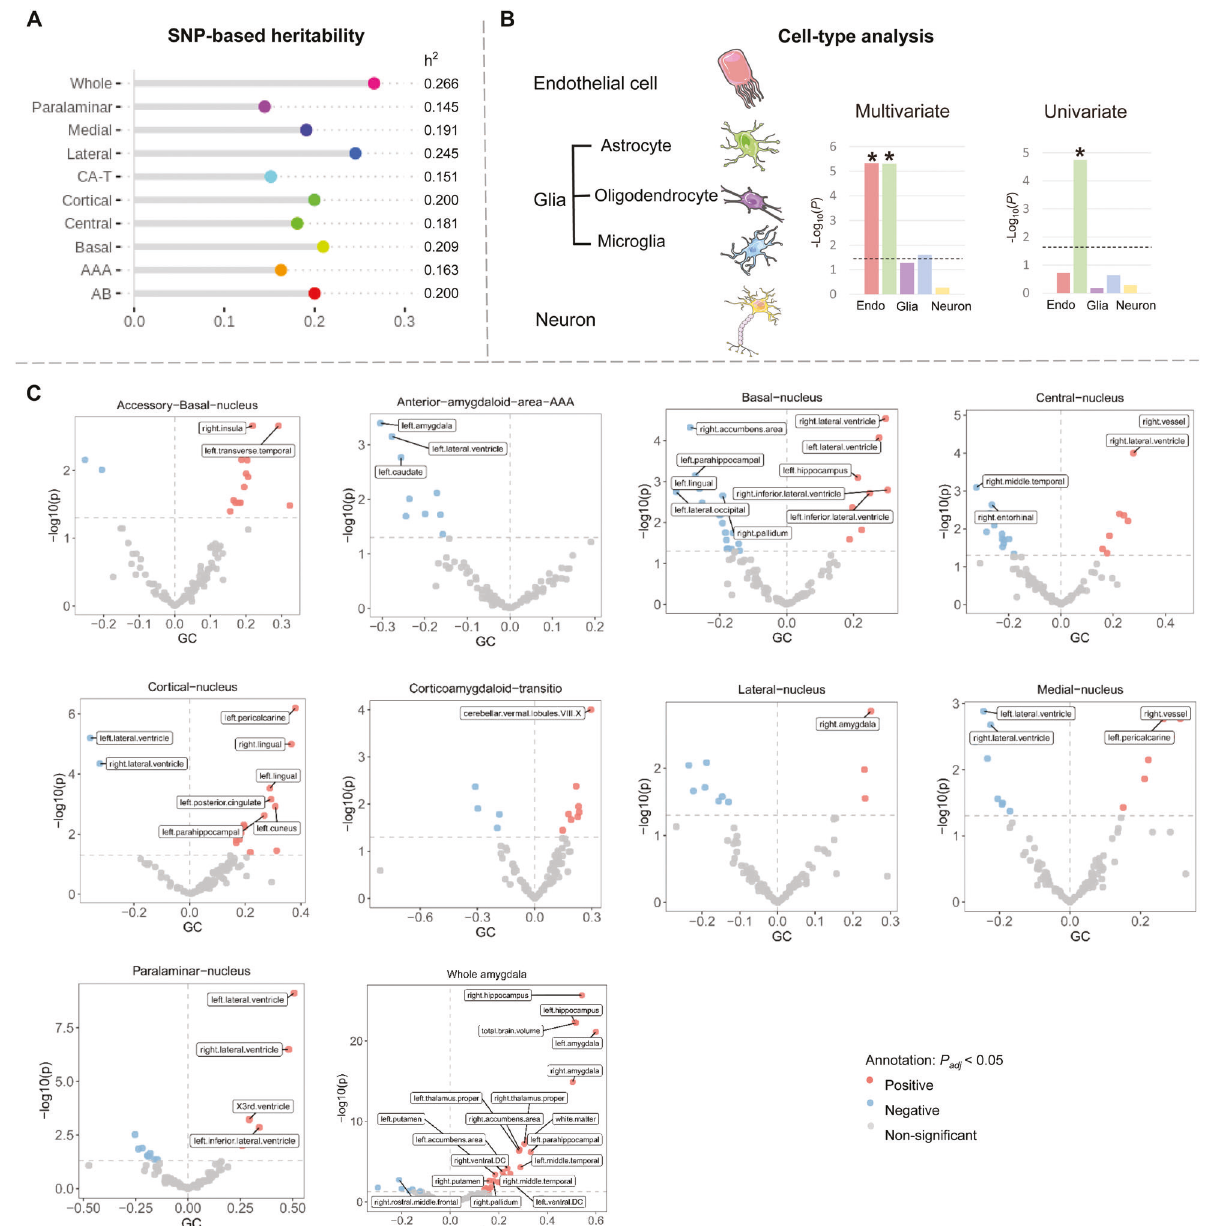
Fig. 4 Heritability estimates and genetic overlap with brain structures. A LDSC-based heritability estimates for the amygdala volumes. All amygdala volumes showed substantial heritability, ranging from 0.145 for corticoamygdaloid transition to 0.266 for the whole amygdala. B Cell-type analysis indicated that most of the genes were signi fi cantly enriched in astrocytes. Left panel represents the signi fi cant association for cell-type analysis was observed for endothelial cells and astrocytes in the multivariate GWAS. Right panel represents that most of the genes were signi fi cantly enriched in astrocytes for the whole amygdala volume in the univariate GWAS. C Volcano plots visualize the genetic correlation estimates between 101 regional brain volumes and accessory-basal, anterior-amygdaloid-area-AAA, basal, central, cortical, corticoamygdaloid transition, lateral, medial, paralaminar nucleus, and whole amygdala volume. Red, blue, and gray dots indicate positive, negative, and non-signi fi cant genetic associations, respectively. Correlation estimates that survived FDR adjustment are annotated with brain region names. SNP single nucleotide polymorphism, AB accessory-basal nucleus, AAA anterior-amygdaloid-area, CAT corticoamygdaloid transition, LDSC linkage disequilibrium score, FDR false discovery performances, SCZ, and BD, 9q22.32 with cognitive traits and annotation represents a genomic region that predates the depression, 17q21.31 with cognitive traits, PD and SCZ, and evolutionary split of marsupial and placental mammals [50]. 19q13.32 with cognitive performances, AD, and LBD. However, 11 of the 32 loci have not been reported to be related to imaging or Concordance with previous studies cognitive/psychiatric traits before, namely the loci of 2q33.3, Most of these loci were previously reported to be related with 2q33.2, 5q21.3, 8p23.1, 8p21.3, 10q11.21, 10q24.31, 14q32.2, brain volume and white matter microstructure traits (Supplemen- 16q23.1, 17q11.2, and 22q13.33. tary Table S13). We noted that 4q24 was related with cognitive